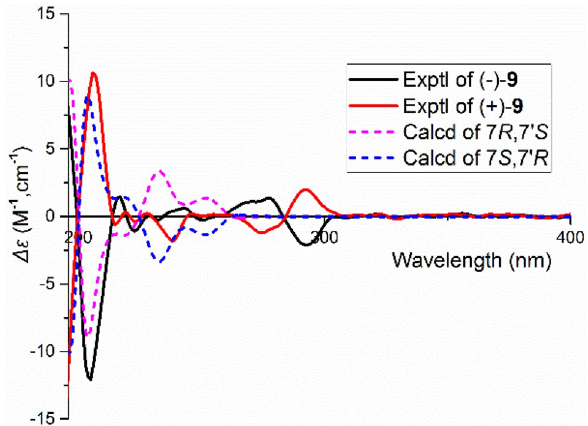
Fig. 5 Comparison of calculated ECD spectra for (8 R ,7 ′ S ,8 ′ R )- 8 and (8 ′ S ,7 ′ R ,8 ′ S )- 8 with the experimental spectra of (+) -8 and (−) -8 in MeOH. σ = 0.3 eV; shift = − 7 nm